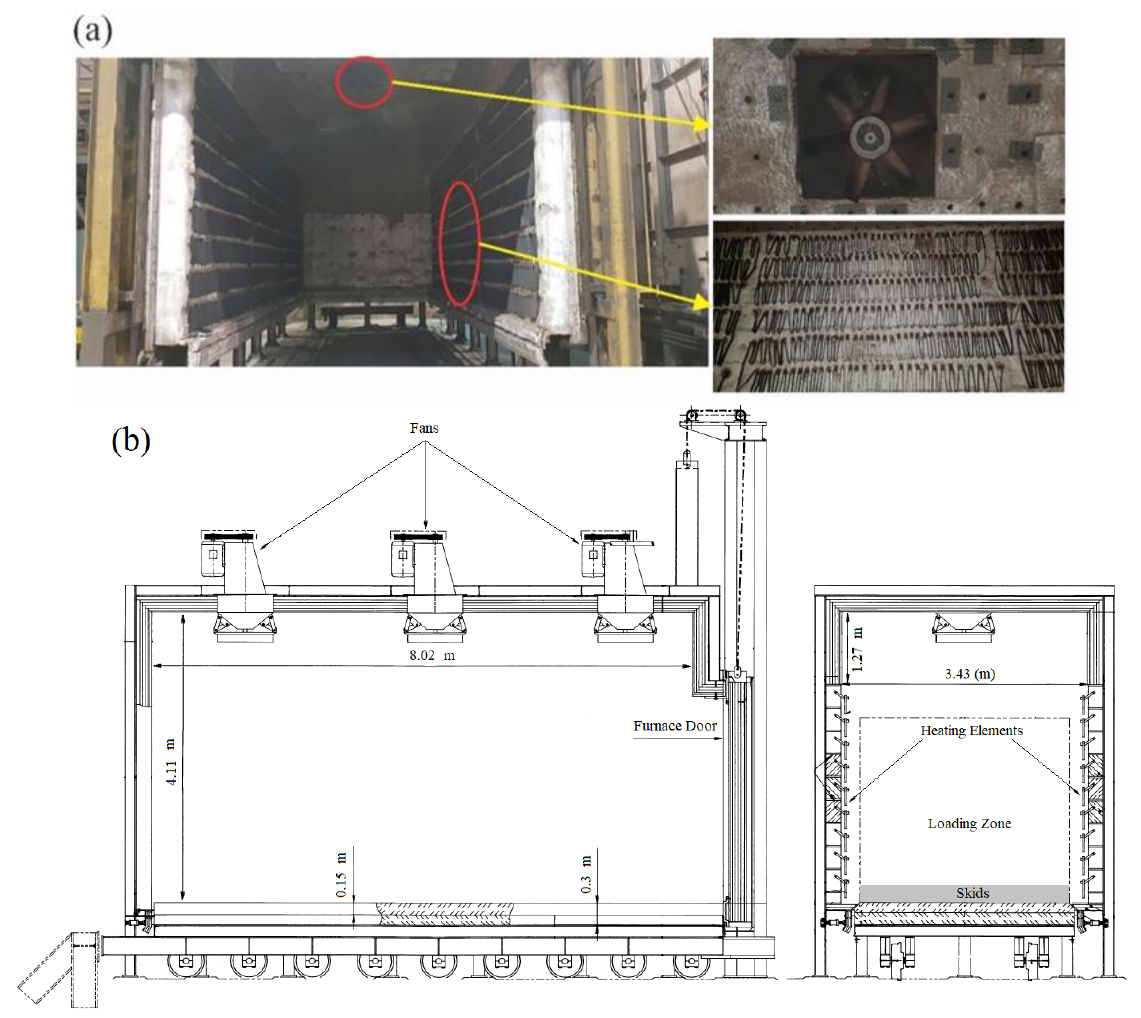
Figure 1. ( a ) Car bottom electrical furnace and ( b ) its corresponding drawings and dimensions